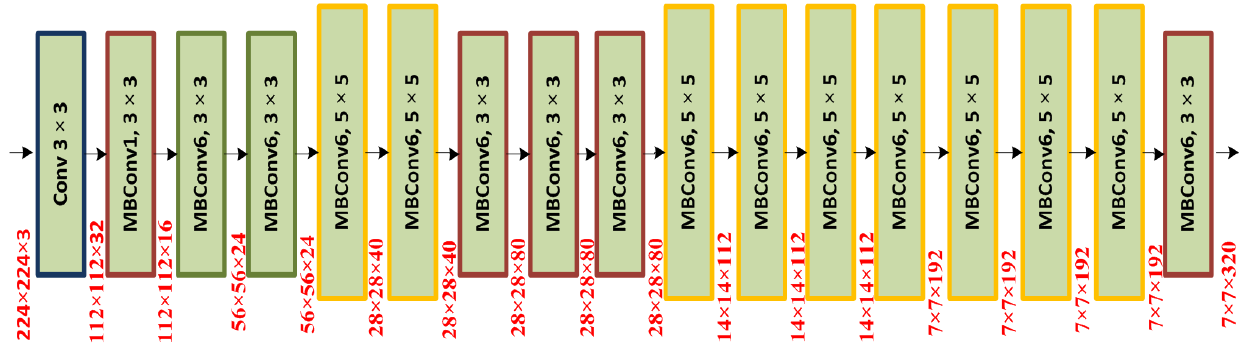
Figure 3. Architectural illustration of the EfficientNet-B0.